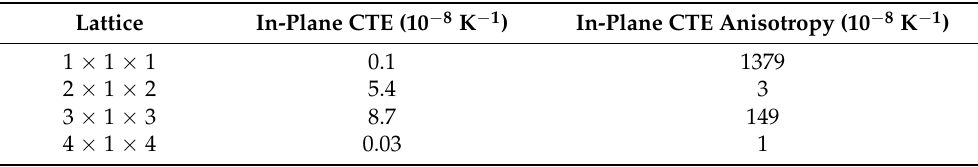
Figure 10. The effect of layer alignment on the deformation of the 2 × 1 × 2 lattice outer part. ( a ) shows an example of the 1st pattern; ( b ) shows an example of the cross-section of the 1st pattern; ( c ) shows an example of the cross-section of the 1st pattern at Layer 2; and ( d ) shows any of the other patterns’ connecting layers. Table 3. The in-plane coefficient of thermal expansion of designs.